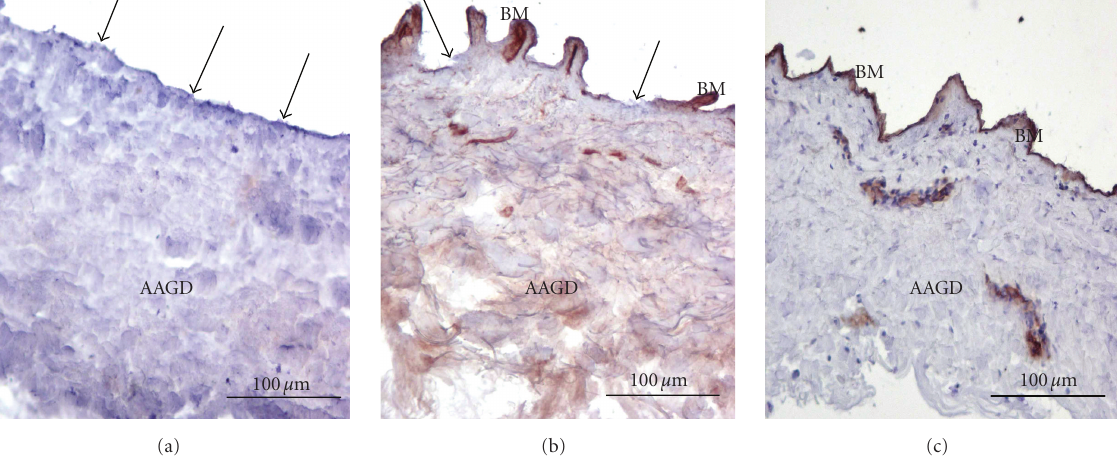
Figure 2: The dermis basement membrane obtained by the three di ff erent techniques stained with Collagen IV MoAb. (a) Dispase II, (b) Trypsin, (c) the manual method. Only the manual method left an integral structure. Arrows indicate the absence of basement membrane. Original magnification: 10x. AAGD: alloplastic acellular glycerolized dermis; BM: basement